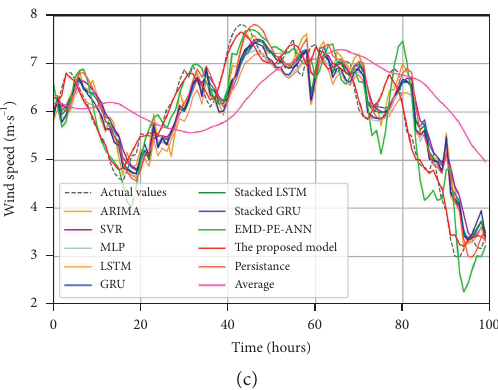
Figure 10: Forecasting results in area 1 of eight models. (a) At the 1st step, (b) at the 2nd step, and (c) at the 3rd